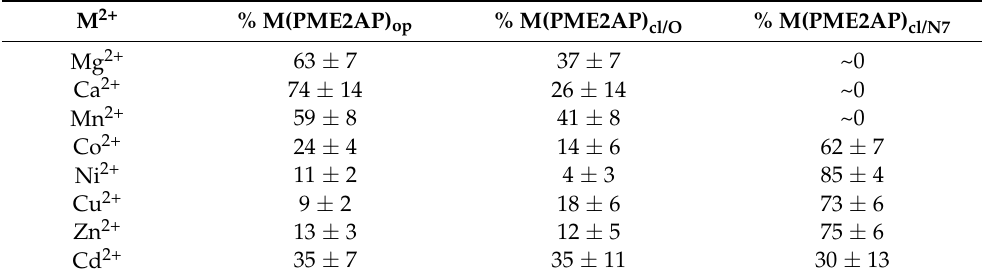
Figure 6. Equilibrium schemes involving various N sites in metal ion complexes of acyclic nucleoside phosphonates containing a purine moiety. Table 3. Formation degrees of the isomeric complexes, M(PME2AP) op , M(PME2AP) cl/O , and M(PME2AP) cl/N7 (Equilibrium Scheme (15) in Figure 6), in aqueous solution at 25 °C and I = 0.1 M (NaNO 3 ) a .